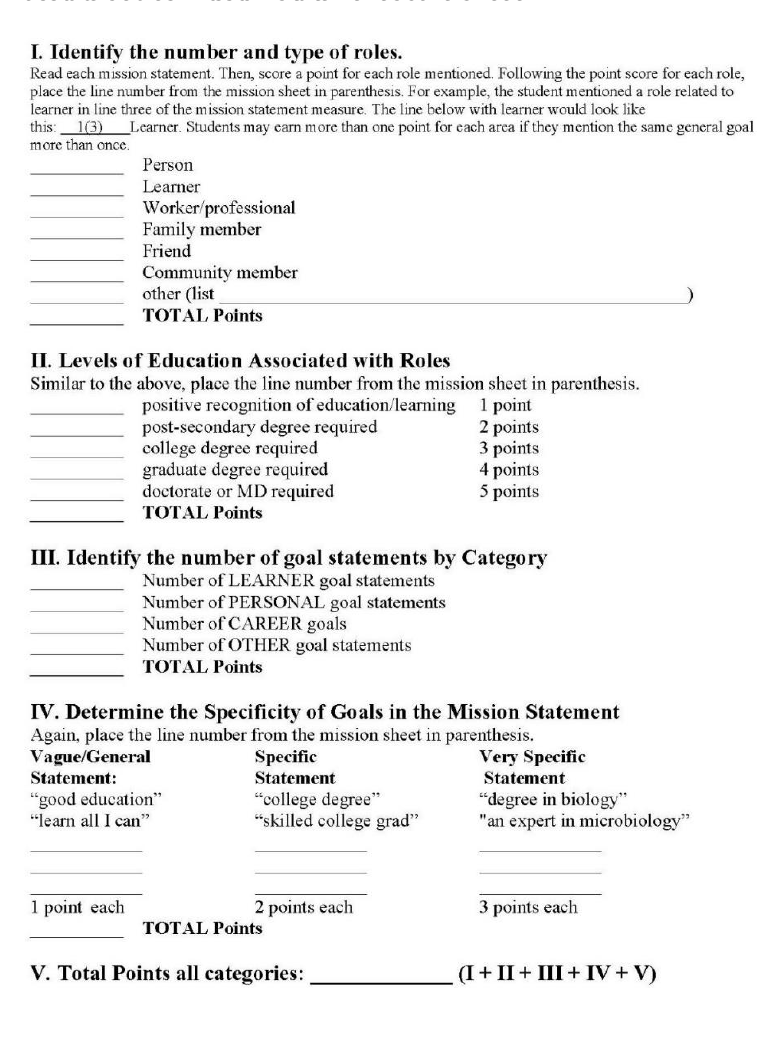
Possible Selves Mission Statement Score